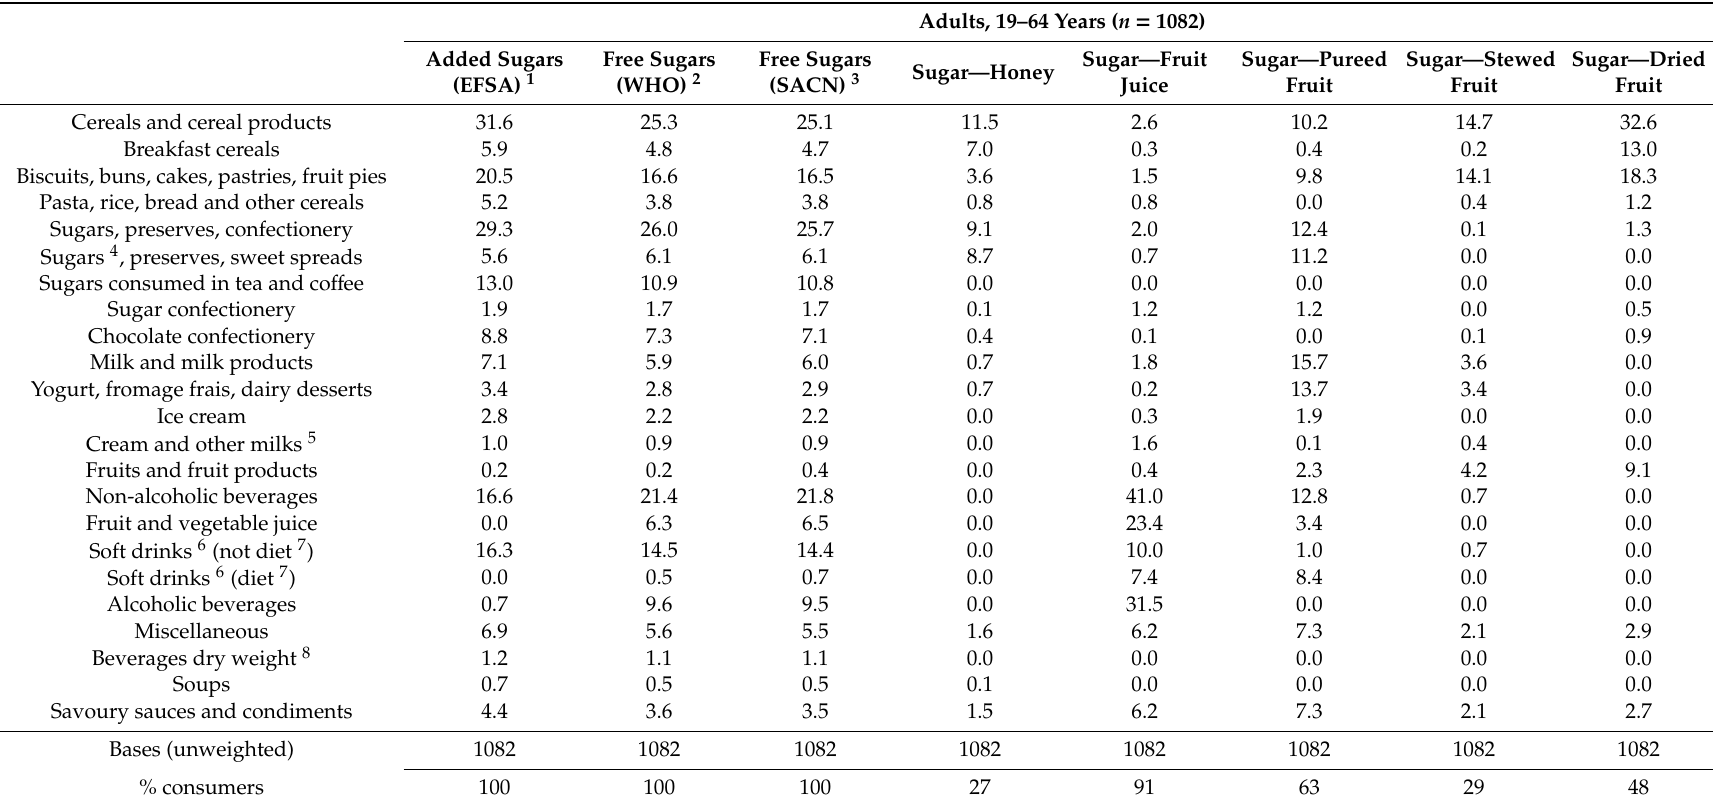
Table 7. Contribution (%) of NDNS RP food group sources to intake of sugars by age (19–64 Years) (NDNS